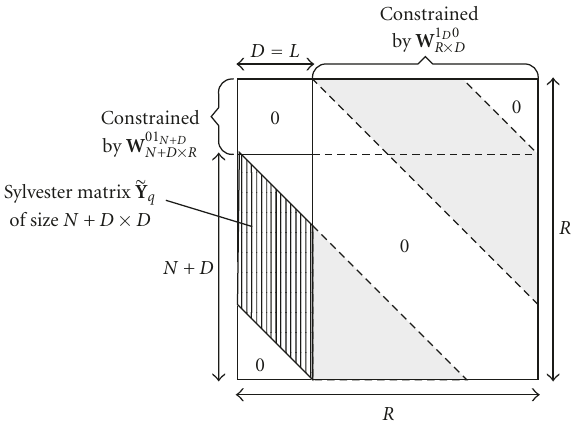
Figure 1: Illustration of (17) showing the relation between circu- and Toeplitz matrix (cid:15) Y q . lant matrix C (cid:15) Y q